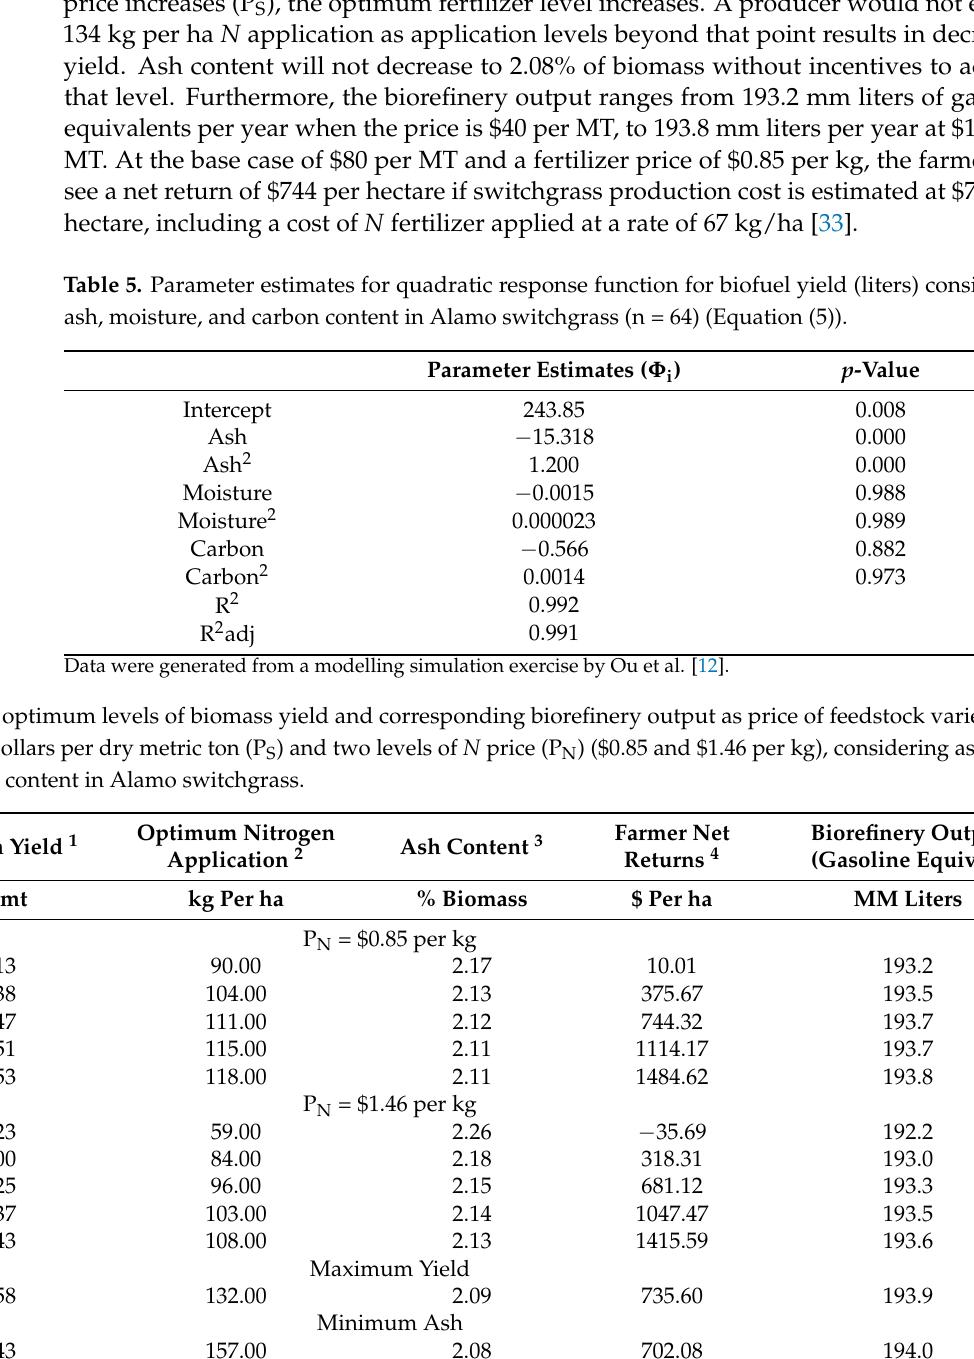
1 Estimated with Equation (4) based on the nitrogen level estimated by Equation (7) and estimates provided in Table 2. 2 Estimated based on Equation (7) assuming the price paid per delivered metric ton of feedstock and the fertilizer price. 3 Estimated based on Equation (4) and estimates provided in Table 2 based on the nitrogen level estimated by Equation (7). 4 According to [21], switchgrass production cost is estimated at $723 per hectare including a cost of N fertilizer applied at a rate of 135 kg/ha valued at $0.85 per kg. 5 Estimated using the biorefinery yield Equation (5) (see Table 3). 6 Baseline optimum